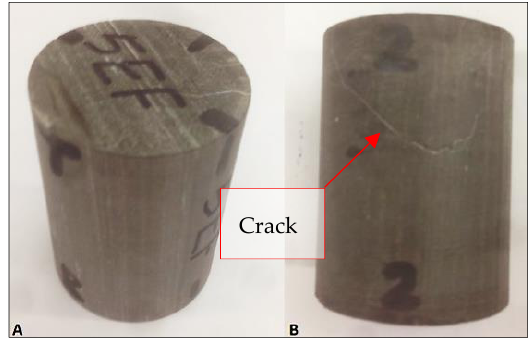
Figure 7. Core sample EF#5 ( A ) BTS and ( B ) after 3rd thermal shock.